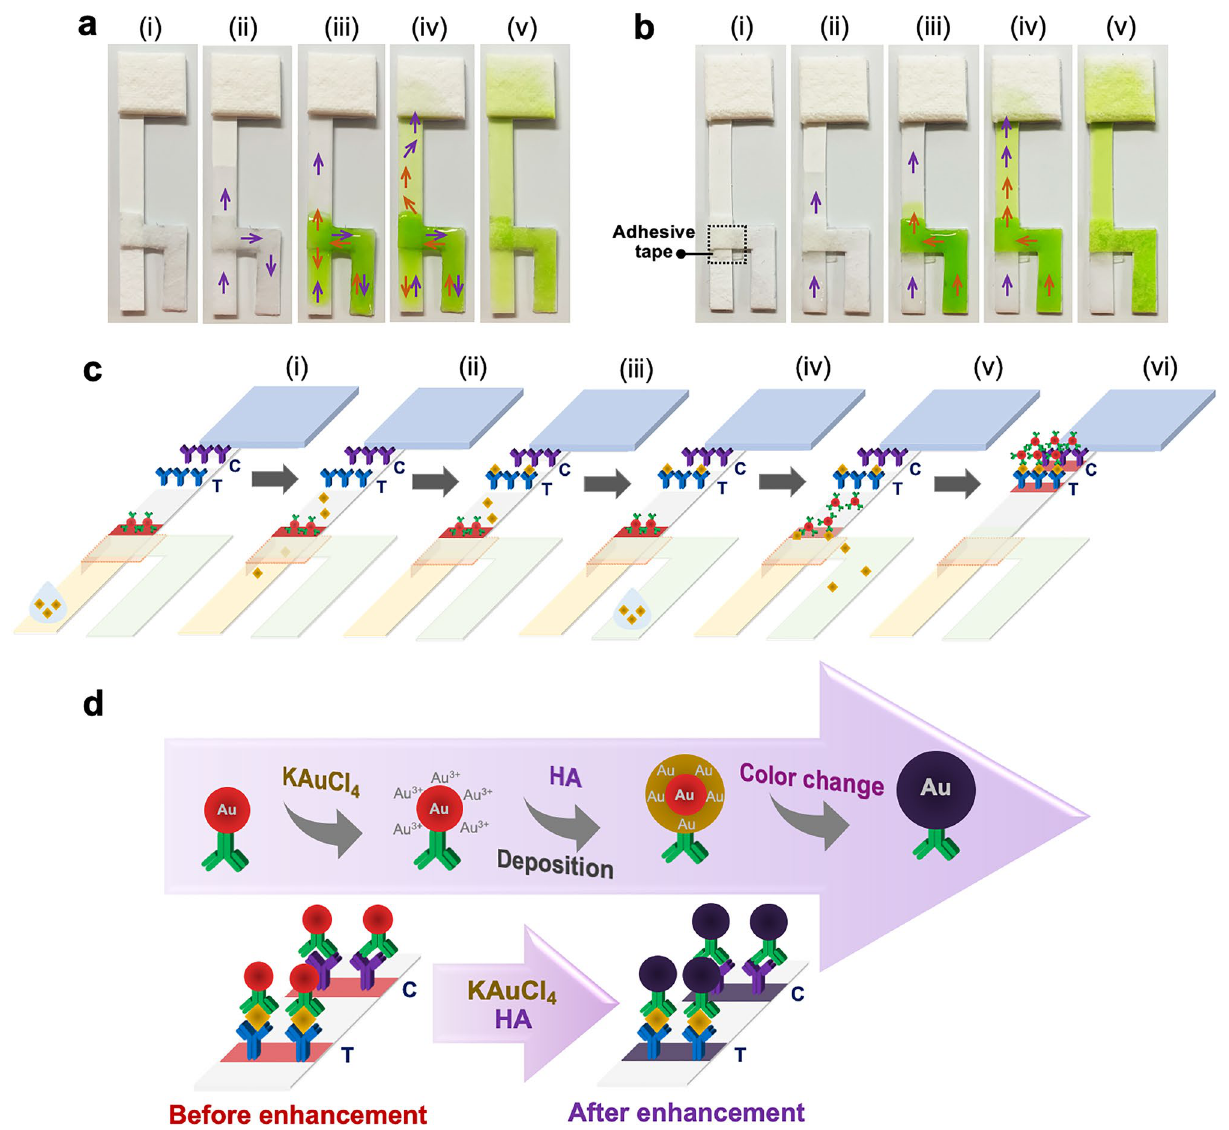
Figure 1. Solution flow on prototype devices ( a ) without and ( b ) with adhesive tape using milli-Q water and a food dye-colored solution as model liquids, with the flow of water (purple arrow) and green liquid (orange arrow) indicated: (1) prototype device before liquid deposition, (2) device after application of water on the first inlet pad, (3) device after application of green liquid on the second inlet pad, (4) device after the absorption of liquids into the absorbent pad, and (5) device after complete flow of solutions; ( c ) principle of the sensitivity improvement of ferritin colorimetric immunoassay using the double-sample inlet device: (1) sample loaded on the sample pad, (2) the target analyte flowing from the sample pad to the NCM, (3) the target analyte captured by the immobilized antibody, (4) sample loaded on the conjugate pad, (5) the free labeled antibody and the target analyte-labeled antibody complex flowing from the conjugate pad to the NCM and (6) the free labeled antibody captured by the target analyte bound to the immobilized antibody, and the target analyte-labeled antibody complex captured by the immobilized antibody, resulting in a red color on T and C lines; ( d ) schematic illustration of the enlargement of AuNPs after gold